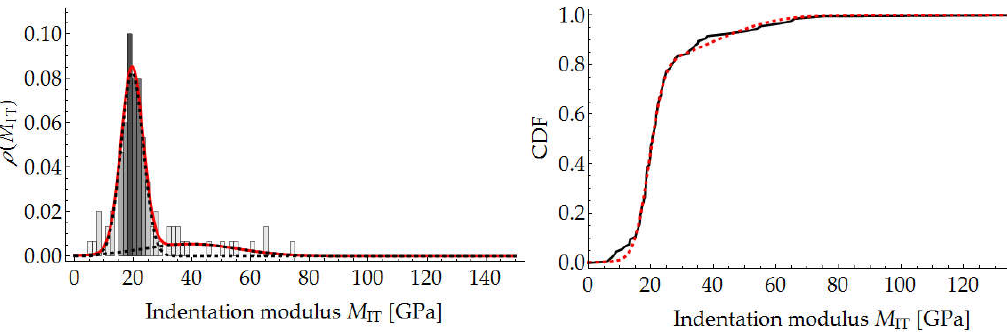
Figure 24. Segmentation of mortar components through deconvolution based on hardness histogram.